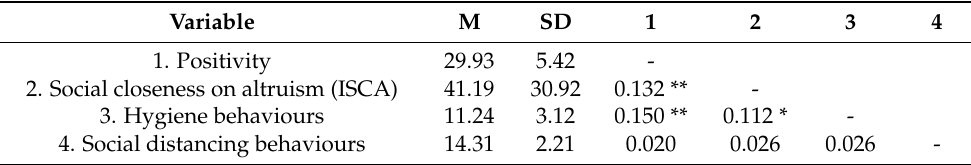
Table 2. Descriptive characteristics of the sample ( n = 460).